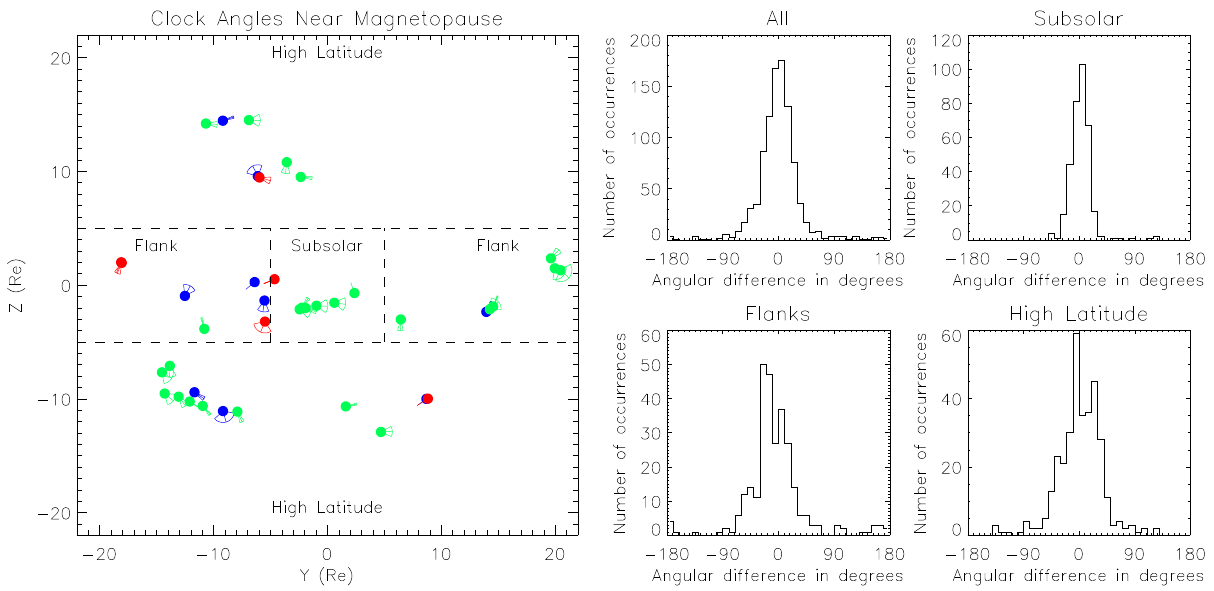
Fig. 8. Clock angles measured near magnetopause, and angular differences from perfect draping, for restricted IMF cone angle. Format as Fig.